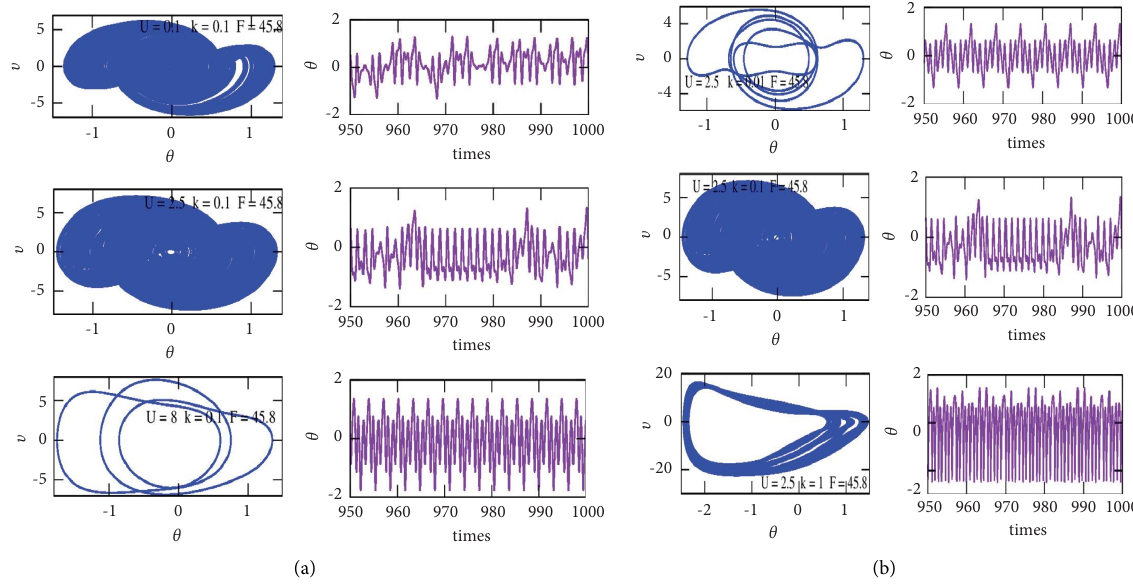
Figure 8: Phase portrait and its time series showing (a) effect of U and (b) effect of K for ϵ � 1 ; α � 10 ; β � 1 ; Ω � 2 ; C 0 . 05 ; M � 0 . 1 ; g �